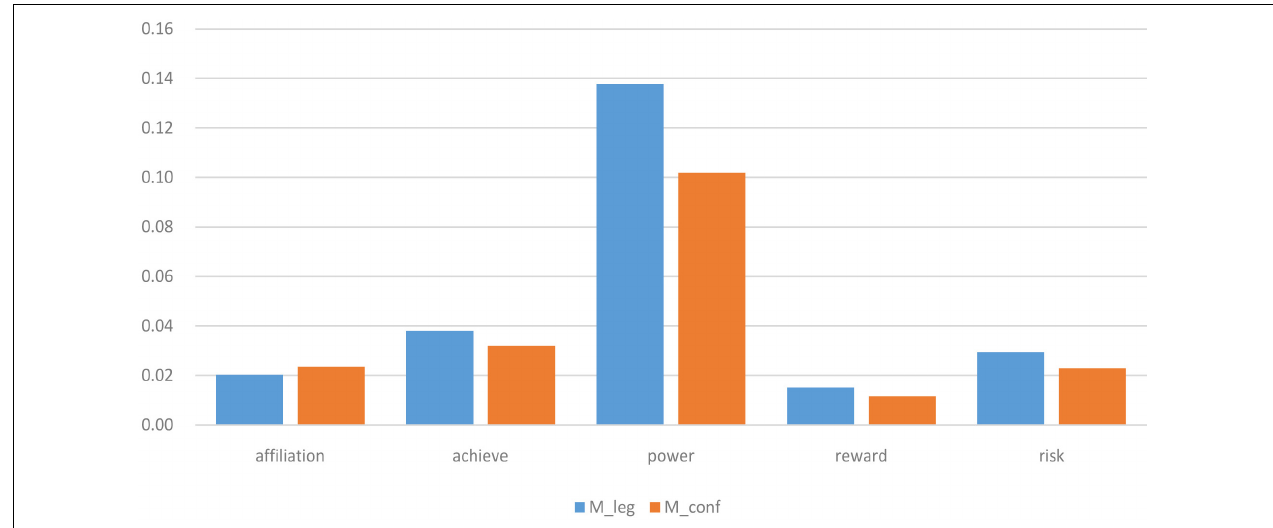
FIGURE 1 | Comparison of average frequencies of each word category in Confucian and Legalist classics. M_leg and M_conf represent the average frequencies of each word category, respectively, in Legalist and Confucian